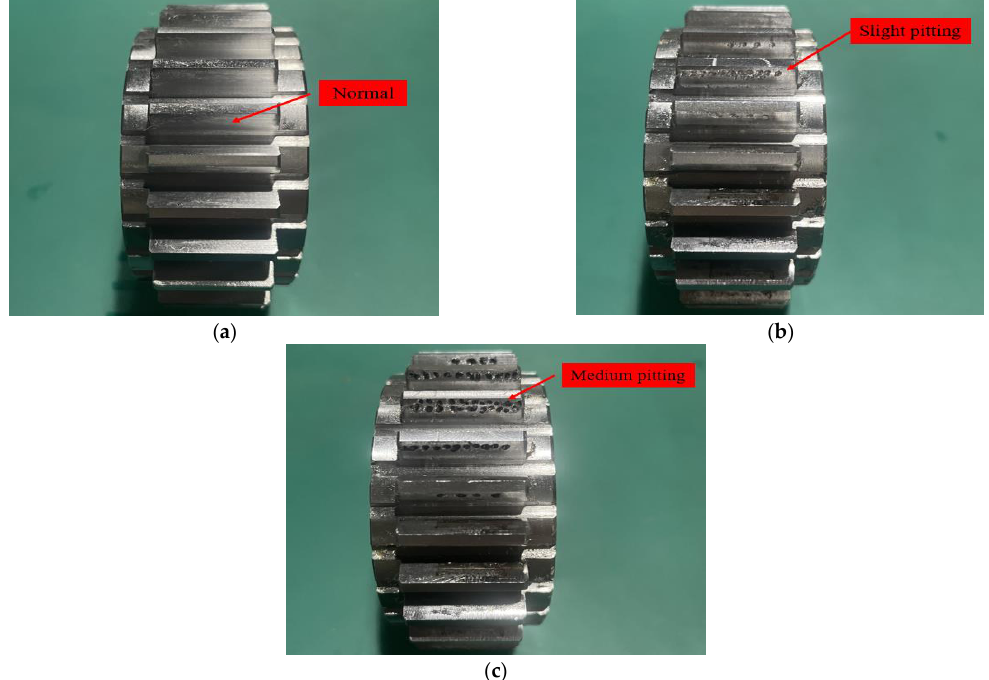
Figure 12. Gear tooth health level. ( a ) Normal condition. ( b ) Slight pitting condition. ( c ) Medium pitting condition.